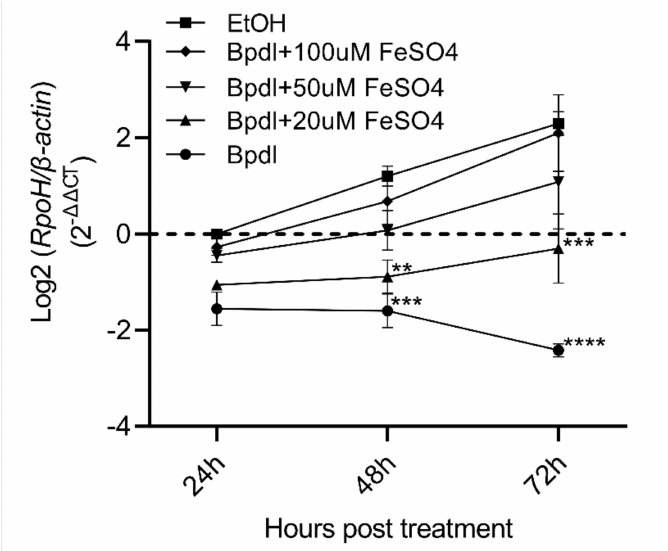
Figure 5. FeSO 4 overwhelmed Bpdl chelation to restore A. marginale levels. There was a dose- dependent increase in A. marginale levels in DAE100 cells that received the iron chelator plus FeSO 4 as compared to cells treated only with the chelator (Bpdl). The y-axis is the log2 of the relative normalized expression of A. marginale rpoH relative to D. andersoni ß-actin . The average ± SEM of four independent replicates is represented by the nodes and error bars. Asterisks indicate statistically significant differences between the carrier-treated cells (EtOH) and all other treatments at each time point. Statistical significance is denoted as follows: ** = p < 0.01, *** = p < 0.001, **** = p <